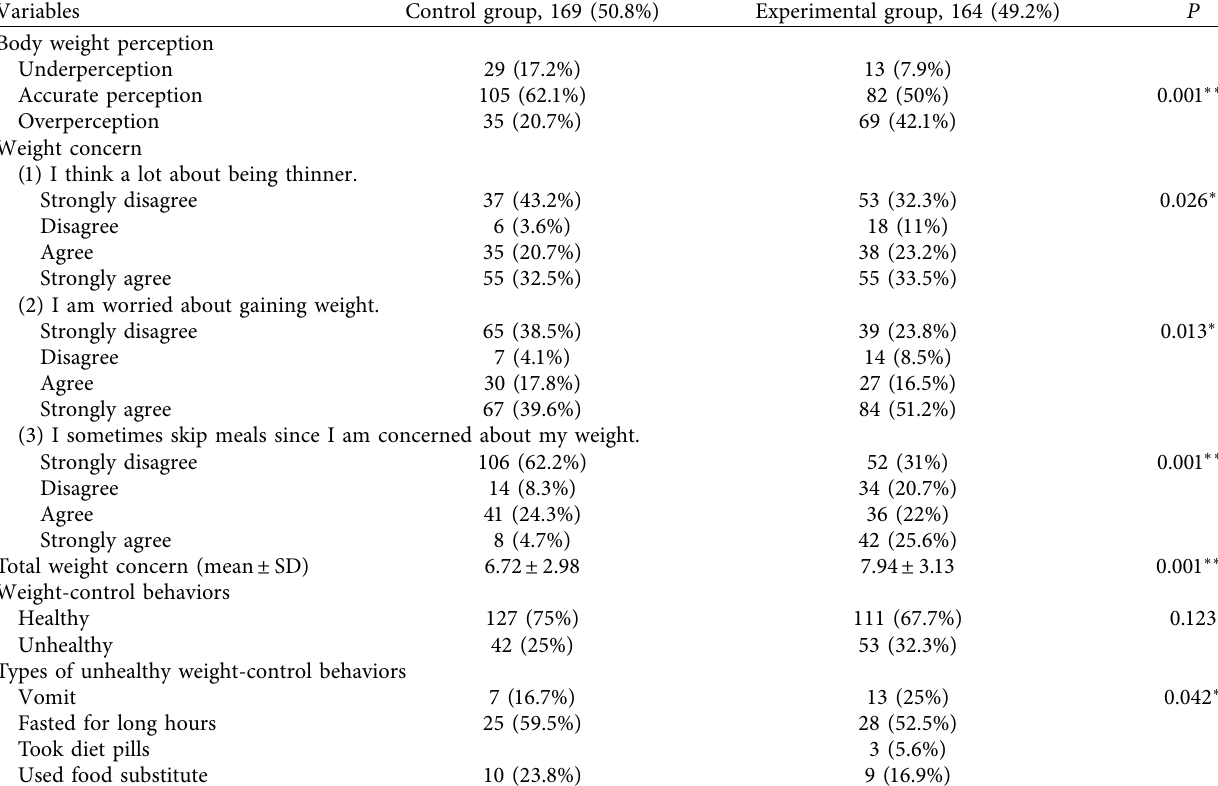
Table 2: Body weight perception, weight concern, and weight-control behaviors in the groups ( N � 333). Variables